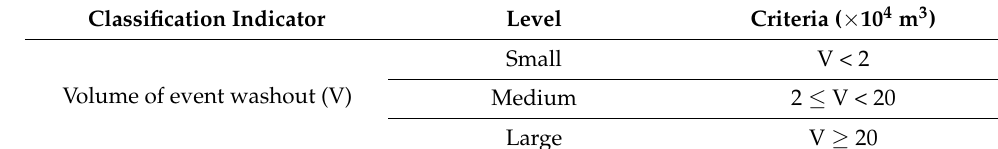
Table 2. Classification of debris flow scale level (extracted from C.4-DZ/T 0261-2014).